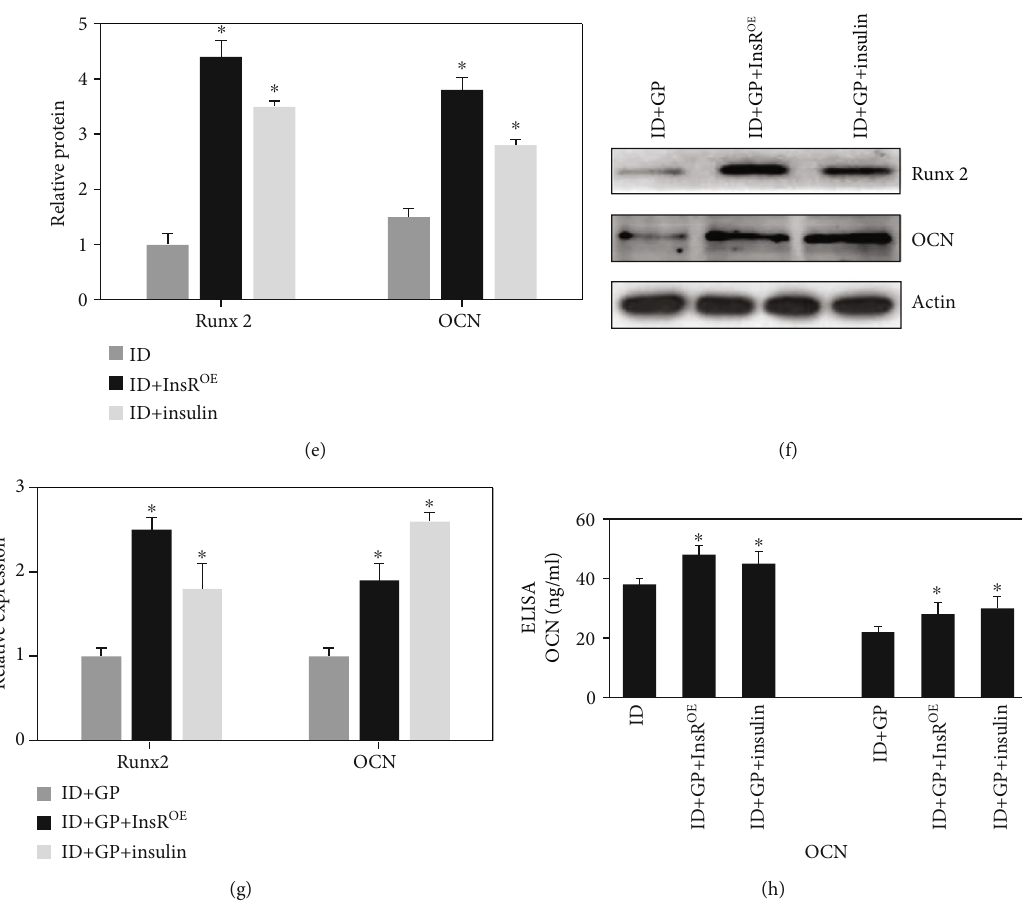
Figure 3: E ff ect of overexpression insulin receptor (InsR OE ) on Runx2 and OCN expression. (a) Establishment of insulin receptor overexpression model. (b) The establishment of insulin receptor overexpression model was validated through immunocytochemistry staining. (c) Mineralization was analyzed through alizarin red staining. (d) The protein expression of Runx2 and OCN was measured through western blotting after treatment with ID, ID+InsR OE , or ID+Insulin. (e) The protein expression of Runx2 and OCN was analyzed. (f) The protein expression of Runx2 and OCN was measured through western blotting after treatment with ID+GP, ID+GP+ InsR OE , or ID+GP +Insulin. (h) The protein expression of Runx2 and OCN was analyzed. (g) The level of OCN was measured with ELISA. Compared with the ID or ID+GP group, ∗ P < 0 : 05 . MC3T3-E1 was used in these